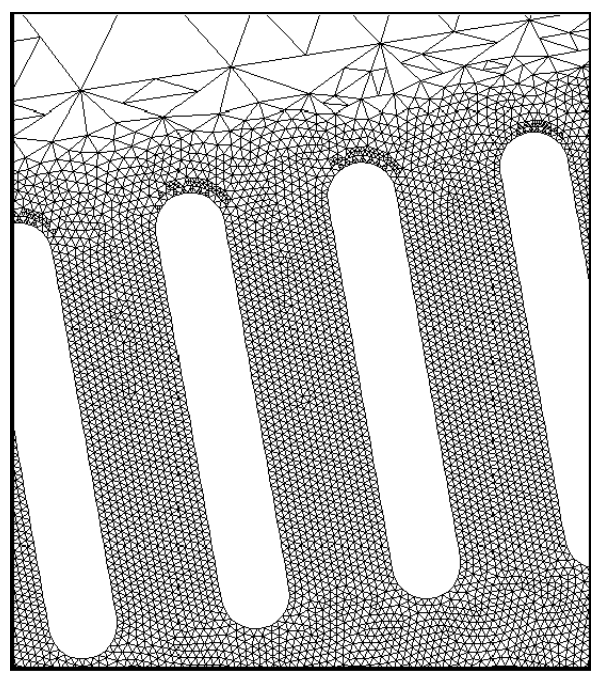
Fig. 8. An example of the discretisation mesh as it was set up in the vicinity of the oval cascade members. The mesh is unstructured triangular, adapted between computation runs by refinement in locations where the absolute magnitudes of local velocity gradient reached values above a limit that was gradually decreased to make the mesh refined. These refinement locations are here seen at the rounded top of the cascade elements, where they improve the solutions inside the boundary